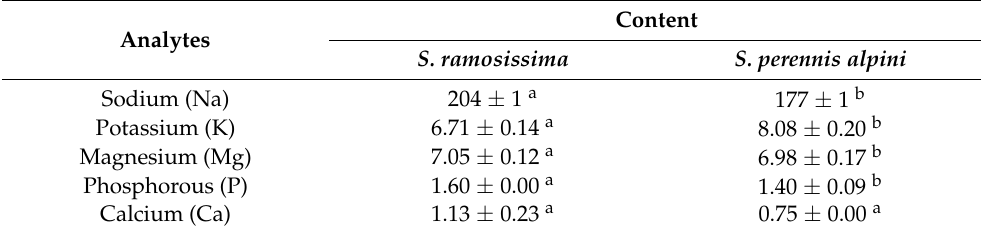
Table 2. Mineral composition (mg/g dw) of the aerial parts of Salicornia ramosissima and Sarcocornia perennis alpini (mean ± SD; n =